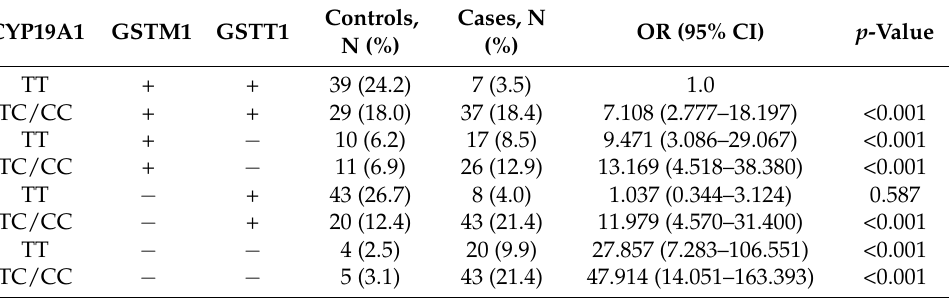
Table 11. Association between CYP19A1 , GSTM1 , and GSTT1 genotype combinations and female